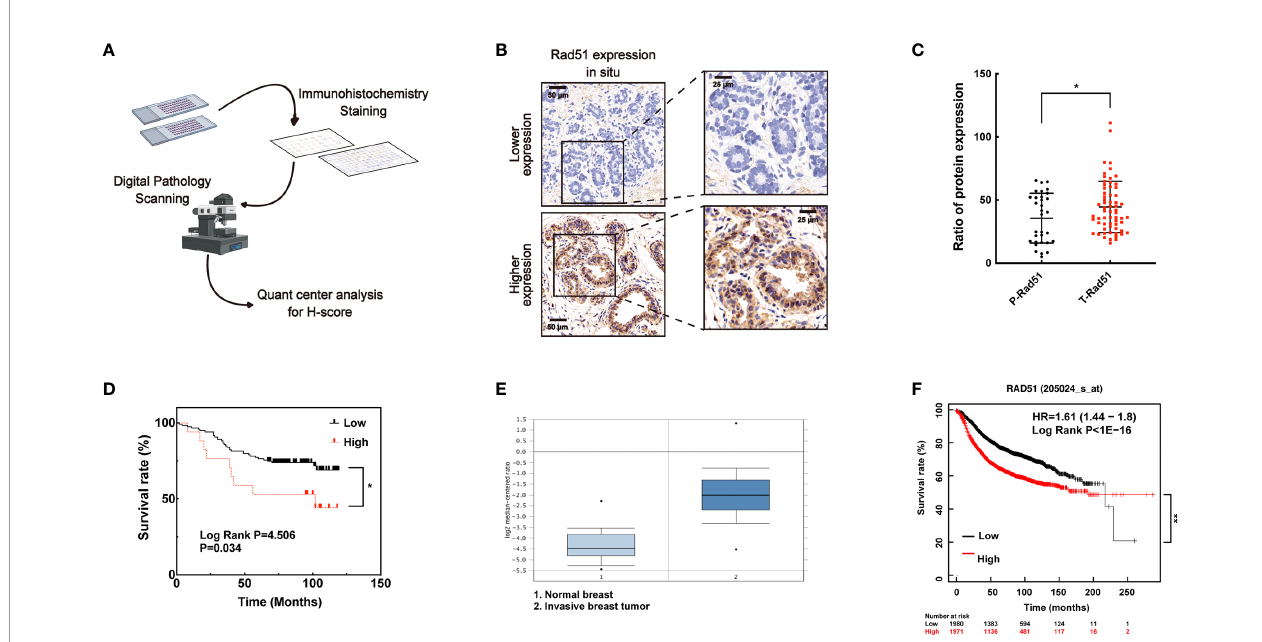
FIGURE 6 | A higher level of Rad51 in human breast cancer may be associated with poor prognosis. (A) Human breast tumor tissue array was stained through immunohistochemistry by speci fi c antibody, slides were digitally scanned and subjected to QuantCenter analysis. H-score was used to value the level of Rad51 expression. (B) Rad51 expression level in para-carcinoma tissues de fi ned the standard of lower and higher level of Rad51 expression in breast tumor tissues. (C) The expression of Rad51 in para-carcinoma (P-Rad51, n = 35) and breast tumor (T-Rad51, n = 101) was counted in the graph. (D) The survival rate of patients who contributed the breast tumor tissue was calculated using the follow-up data of 120 months. (E) Rad51 expression level on a concomitant dataset was used to con fi rm the fi ndings on tissue array. (F) Kaplan-Meier plotter (http://kmplot.com) was used to evaluate the association between prognosis and Rad51 expression. The number of patients who survived at different follow-up times was listed below the graph. Each data point in the graph was from three independent experiments (mean ± SD); P -values were calculated by t-test (* P < 0.05, ** P <